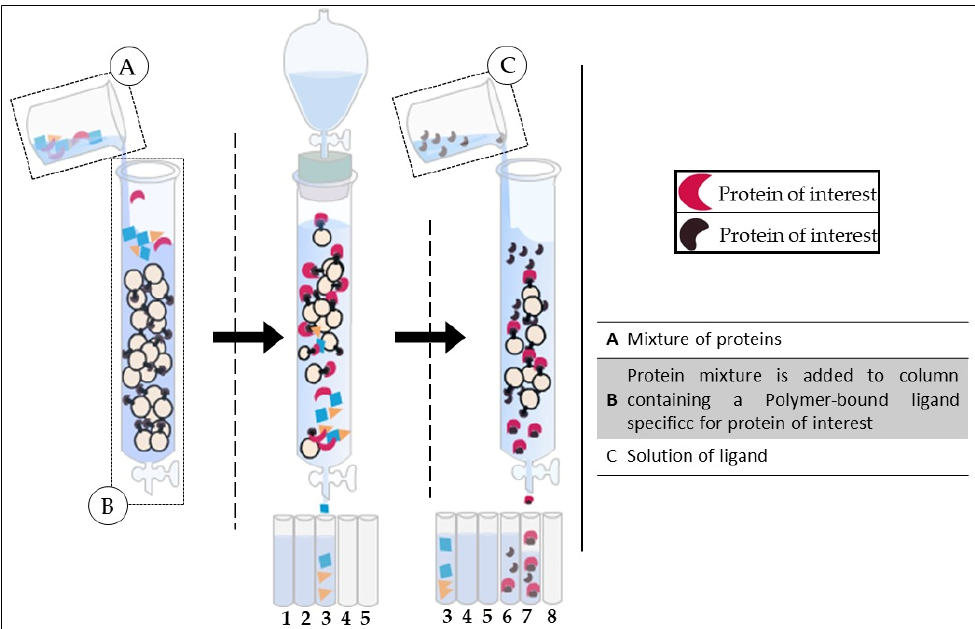
Figure 3. Affinity chromatography for separating biomolecules.